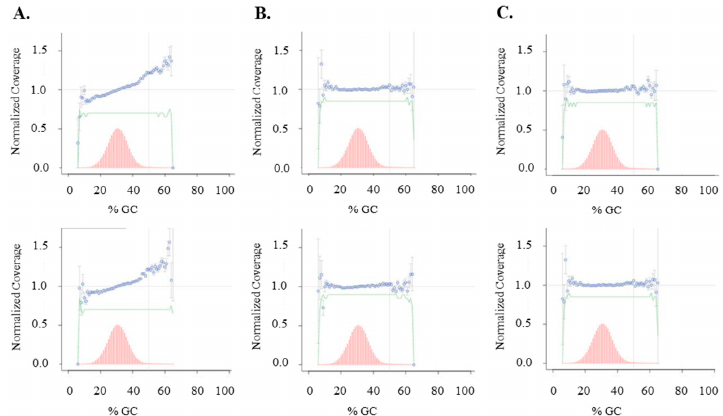
Figure 7. Comparison of Illumina library construction of AT-rich Clostridium acetobutylicum genome. Sequence coverage GC-bias curves obtained from three sets of PCR-free DNA libraries generated with untagged soluble enzymes ( A ) or enzymes immobilized on BG-beads with end repair performed at 20 °C ( B ) or 37 °C ( C ). Each set of libraries was prepared in duplicate (top and bottom). Sequencing reactions were carried out on an Illumina MiSeq.